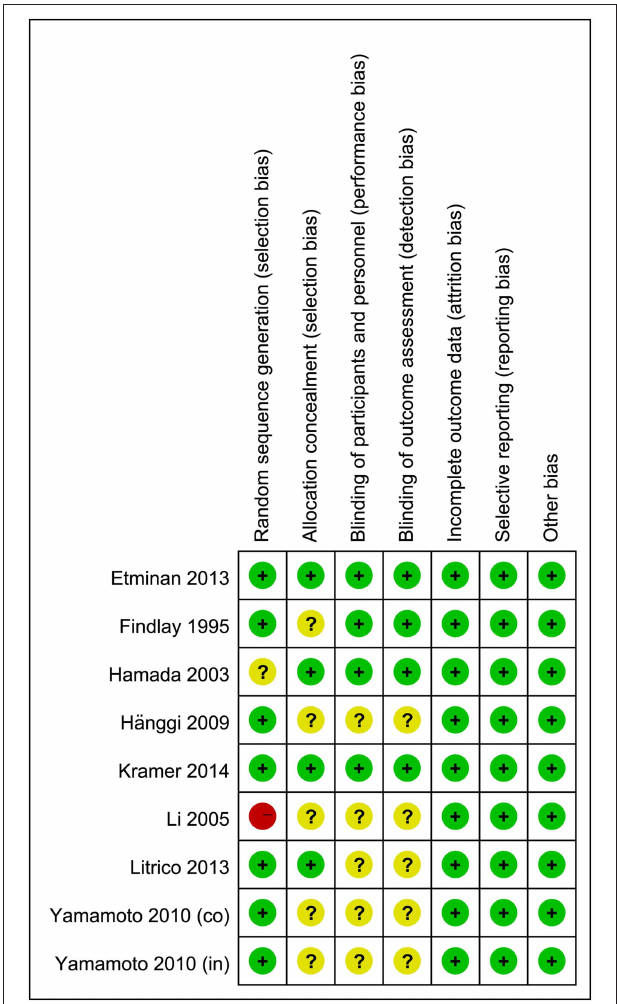
FIGURE 2 | Risk-of-bias assessment for randomized controlled trials. A plus sign ( + ) indicates a low risk of bias, a minus sign (–) indicates a high risk of bias, and a question mark (?) indicates an unclear risk of